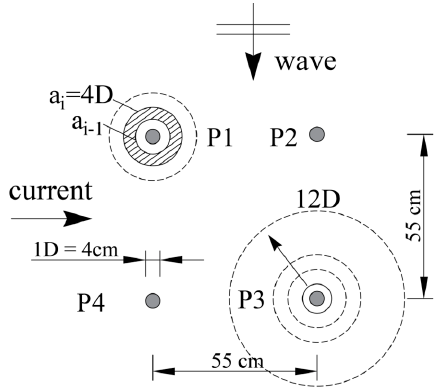
Figure 12. Schematic showing the increasing circle interrogation areas a i around pile (P1–P4), illustrated exemplarily for a circle area a i with a diameter of 4 D for pile 1, related to Equation (6).